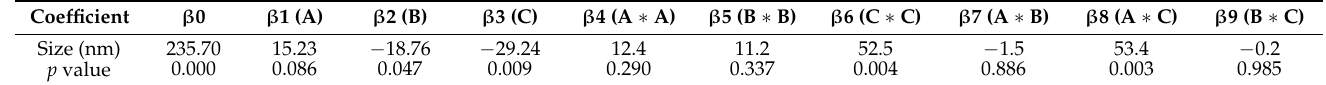
Table 5. Summary of regression coefficient analysis for the response Y1 (Size).